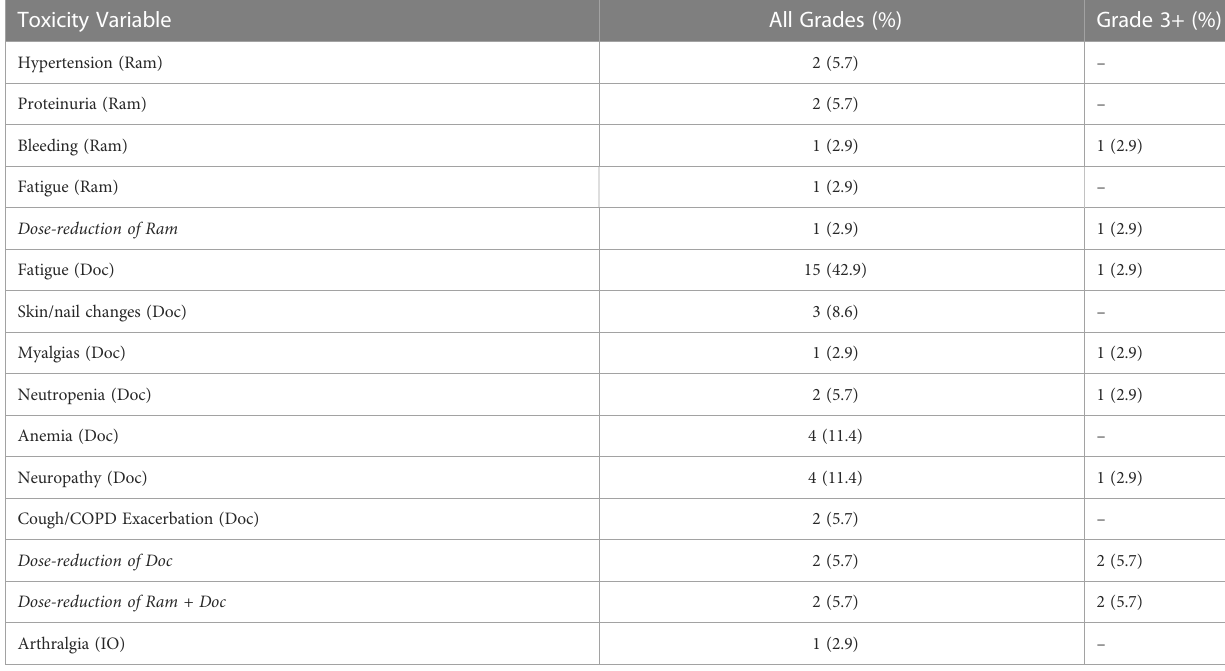
TABLE 2 Treatment-related adverse events related to ramucirumab and docetaxel among patients in the UM Cohort. Toxicity